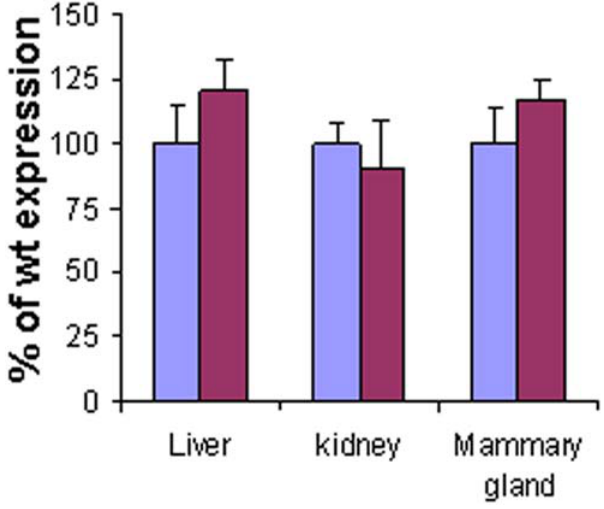
Figure 5. Hpa2 expression. RNA samples derived from liver, kidney and mammary glands of wt and Hpse- KO mice were subjected to quantitative real time PCR analysis to evaluate the expression of Hpa2. The expression level determined for each MMP in the wt tissue (blue) was regarded as 100% and the corresponding expression level determined in the Hpse- KO tissue (purple) is presented as percentage relative to the 100% value. Each reaction was repeated 6 times and the mean 6 SD is indicated. No significant difference was detected in Hpa2 expression between wt and Hpse- KO mice.